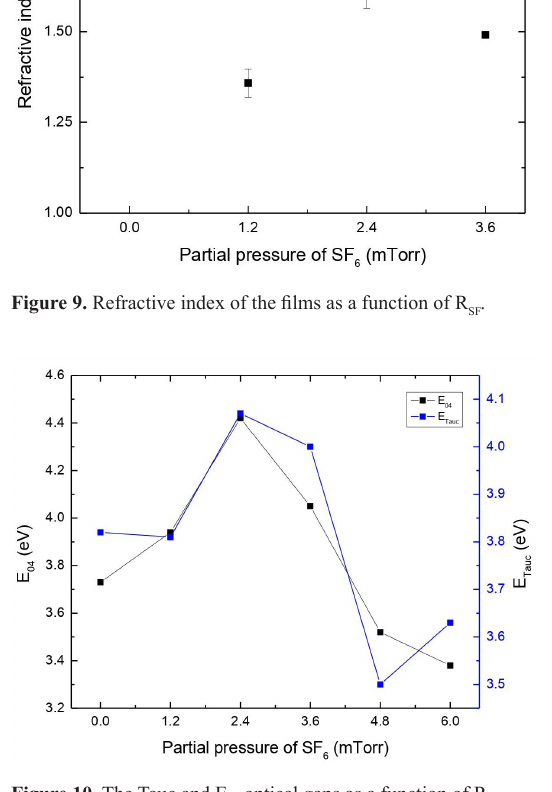
Figure 10. The Tauc and E